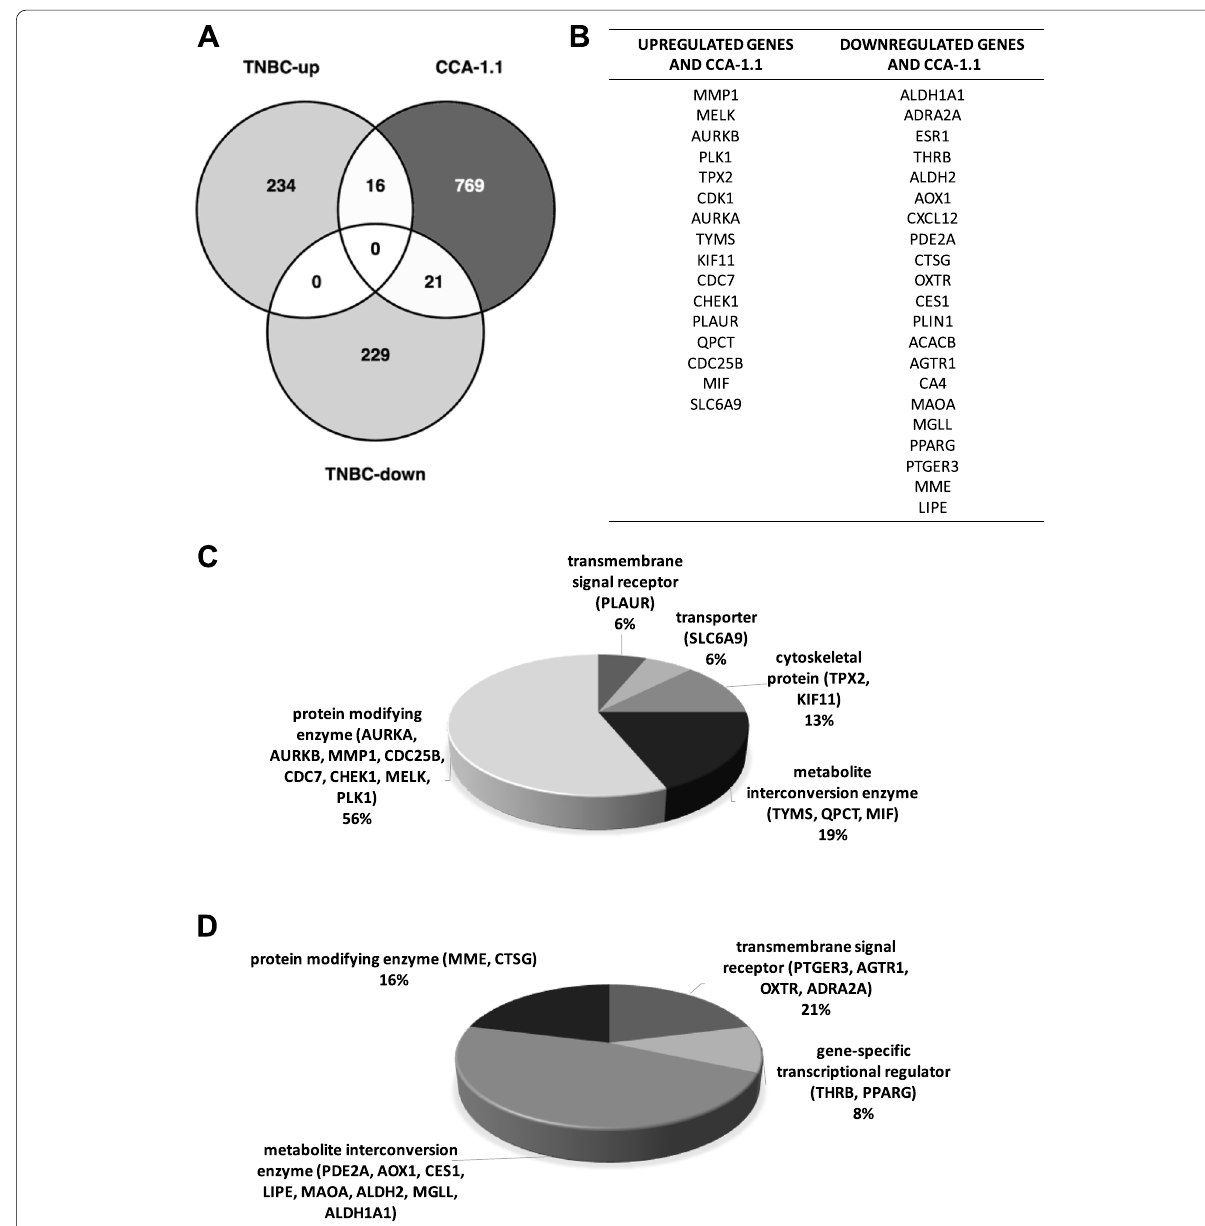
Fig. 2 Several CCA‑1.1 target genes overlapped with TNBC biomarkers from The CGA database, according to Venn diagram ( A ), resulted in a total of 37 potential therapeutic targets of CCA‑1.1 (CPTGs) as listed in table ( B ). The classification of genes based on their protein class using PANTHER for the upregulated genes ( C ) and downregulated genes (D) overlapped with